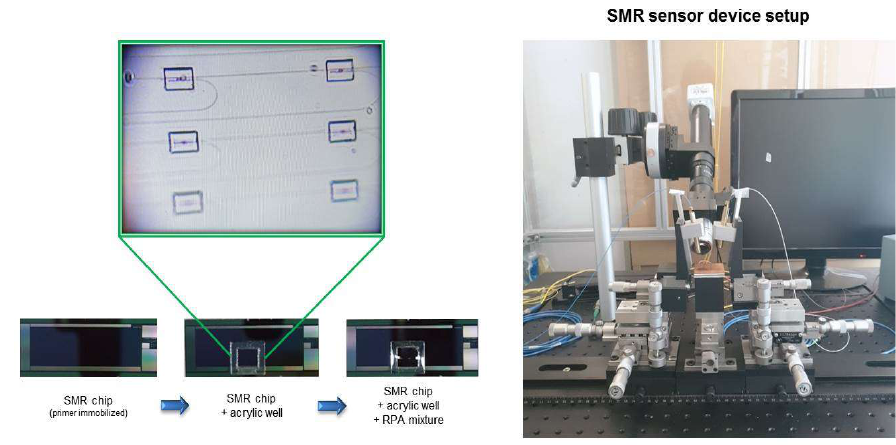
Figure 2. Images of the SMR chip and SMR sensor device setup.